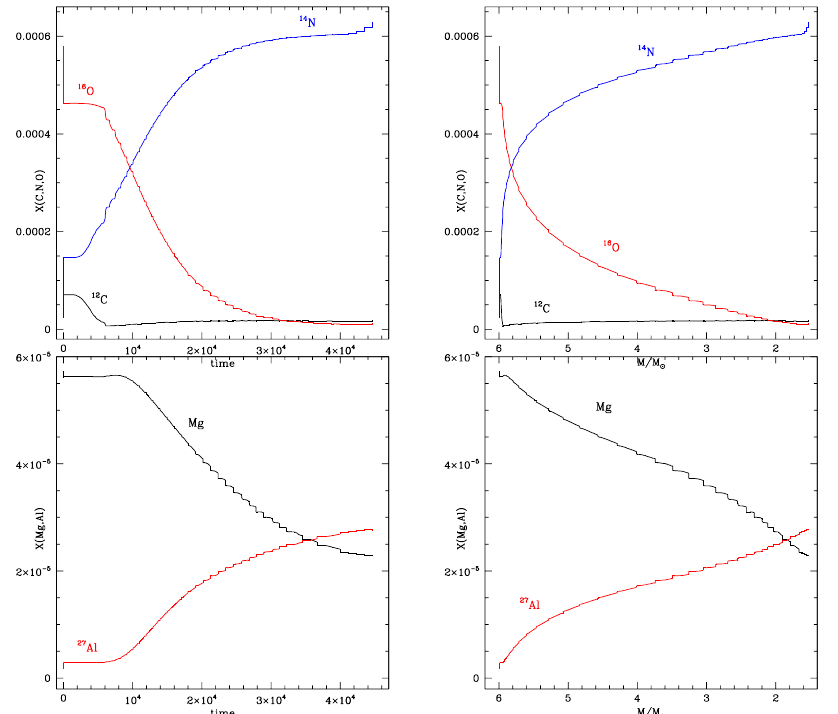
Figure 2. The variation of the surface chemical composition of a 6 M (cid:12) model star of metallicity Z = 10 − 3 in terms of the abundances of the most stable isotopes taking part to the CNO nucleosyn- thesis ( upper panels ) and of magnesium and aluminium ( bottom panels ). The various quantities are shown in terms of the AGB lifetime ( left panels ) and of the current mass of the star ( right panels